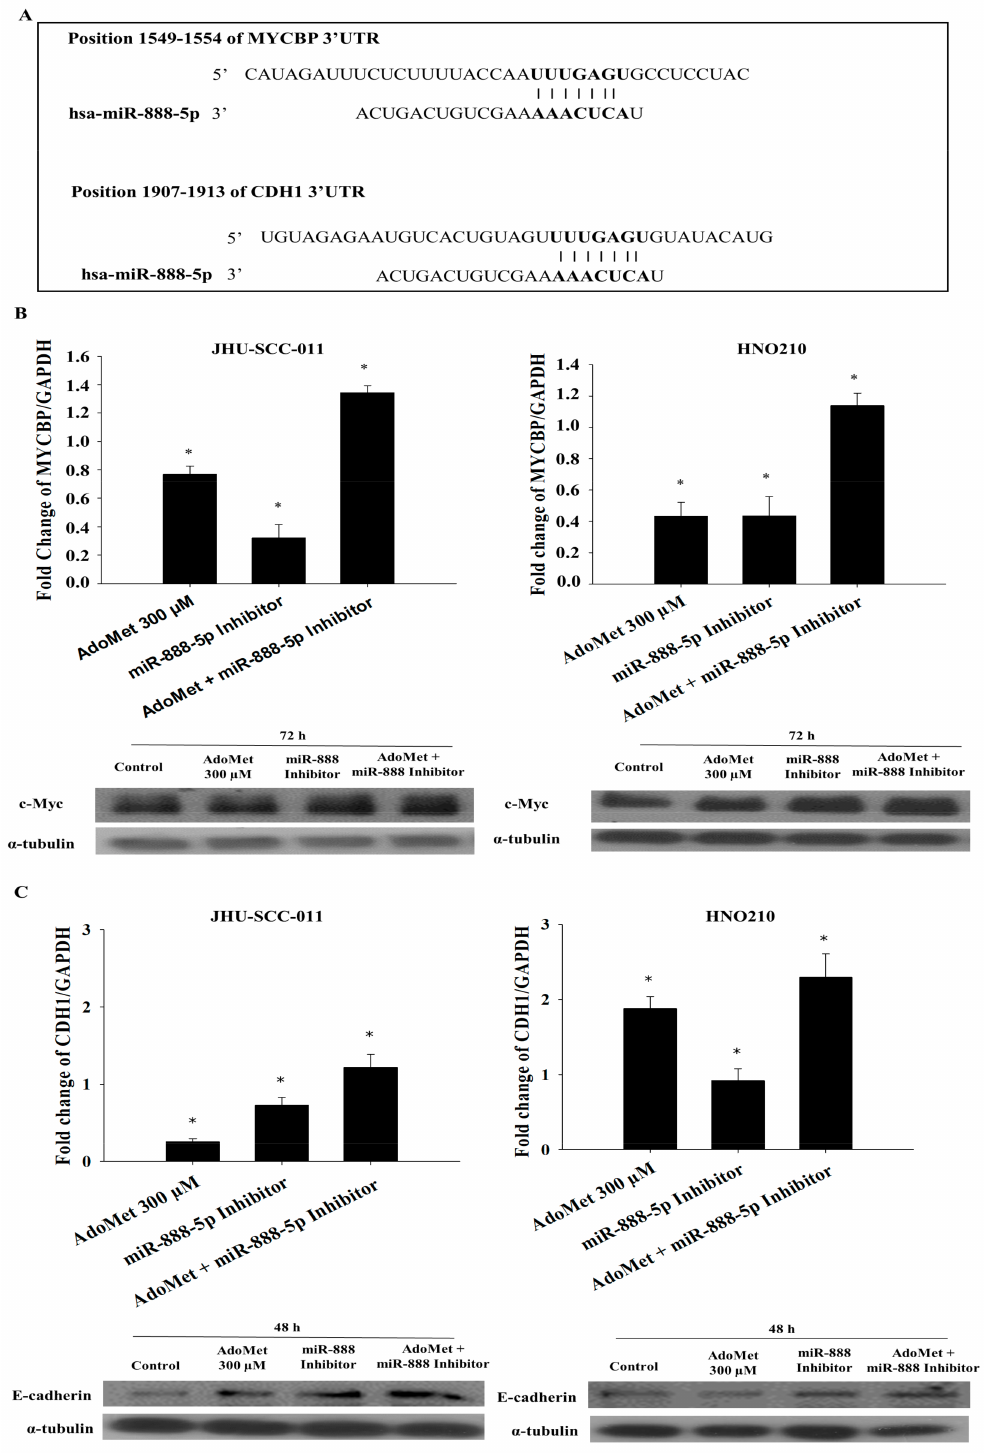
Figure 6. E ff ect of AdoMet and miR-888-5p inhibitor on MYCBP and CDH1 expression. ( A ) Alignment of miR-888-5p with MYCBP or CDH1 3 (cid:48) UTR obtained from miRNA-mRNA integration analysis using the TargetScan microRNA target prediction software. ( B , C ) Cells were transfected with miR-888-5p inhibitor in the presence or not (Control) of 300 µ M AdoMet for 48 and 72 h. Total-RNA of JHU-SCC-011 and HNO210 cells was extracted and cDNA was synthesized by qRT-PCR, to analyze the transcriptional level of predicted target. The graphs show the fold change ( B ) of MYCBP or ( C ) CDH1 in the di ff erent experimental conditions normalized to GAPDH mRNA and compared to untreated cells.